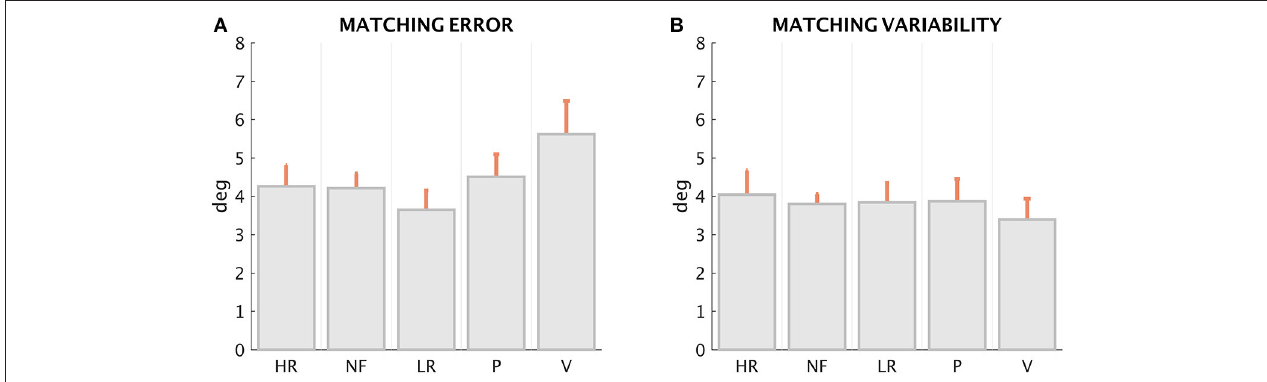
FIGURE 5 | Matching error (A) and Matching variability (B) , mean ± SE of the 12 subjects, in the five loading conditions.